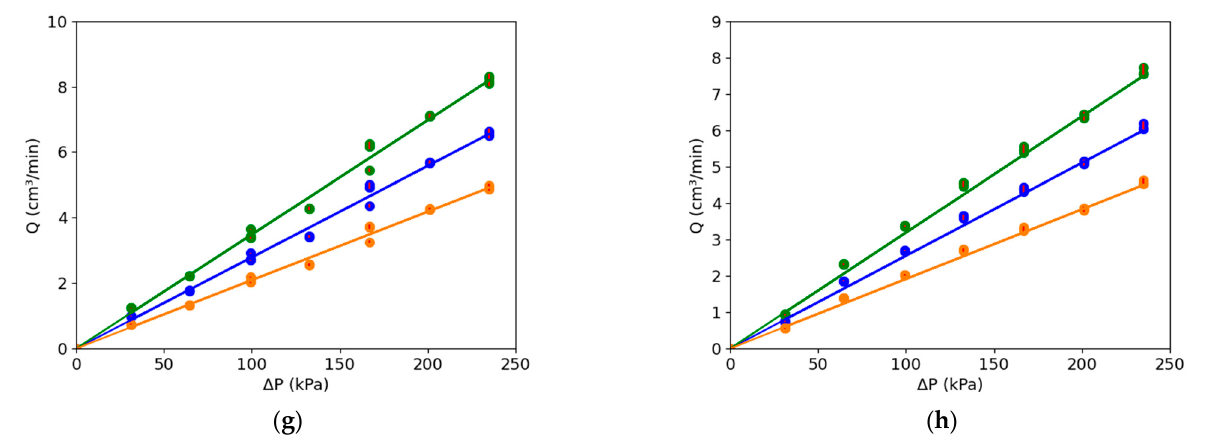
Figure 9. The average outflow versus the pressure drops across MCC PH101 tablets obtained at ( a ) 60 MPa, ( b ) 80 MPa, ( c ) 100 MPa, ( d ) 120 MPa, ( e ) 140 MPa, ( f ) 160 MPa, ( g ) 180 MPa, and ( h ) 200 MPa. The laminar domain is between the upper (+25%) and lower limit ( − 25%).